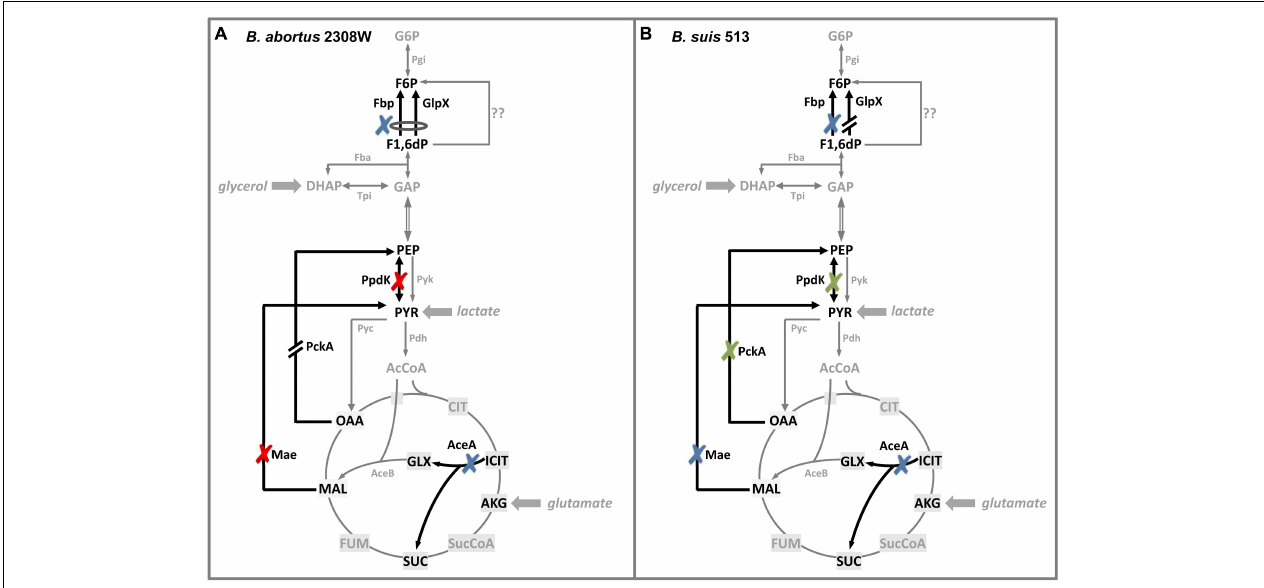
FIGURE 8 | Summary of the results of the central C metabolism enzymes in B. abortus 2308W (A) and B. suis 513 (B) . Glycolysis, gluconeogenesis, TCA cycle, and glyoxylate shunt are shown. Black arrows indicate the steps studied in Zúñiga-Ripa et al. (2014) and in this work. Red crosses indicate attenuated mutants, green crosses specify attenuation when those deletions are combined, blue crosses show steps whose deletion does not affect virulence, broken arrows indicate inactive genes and question marks indicate undescribed enzymes/pathways (for abbreviations, see Figure 1